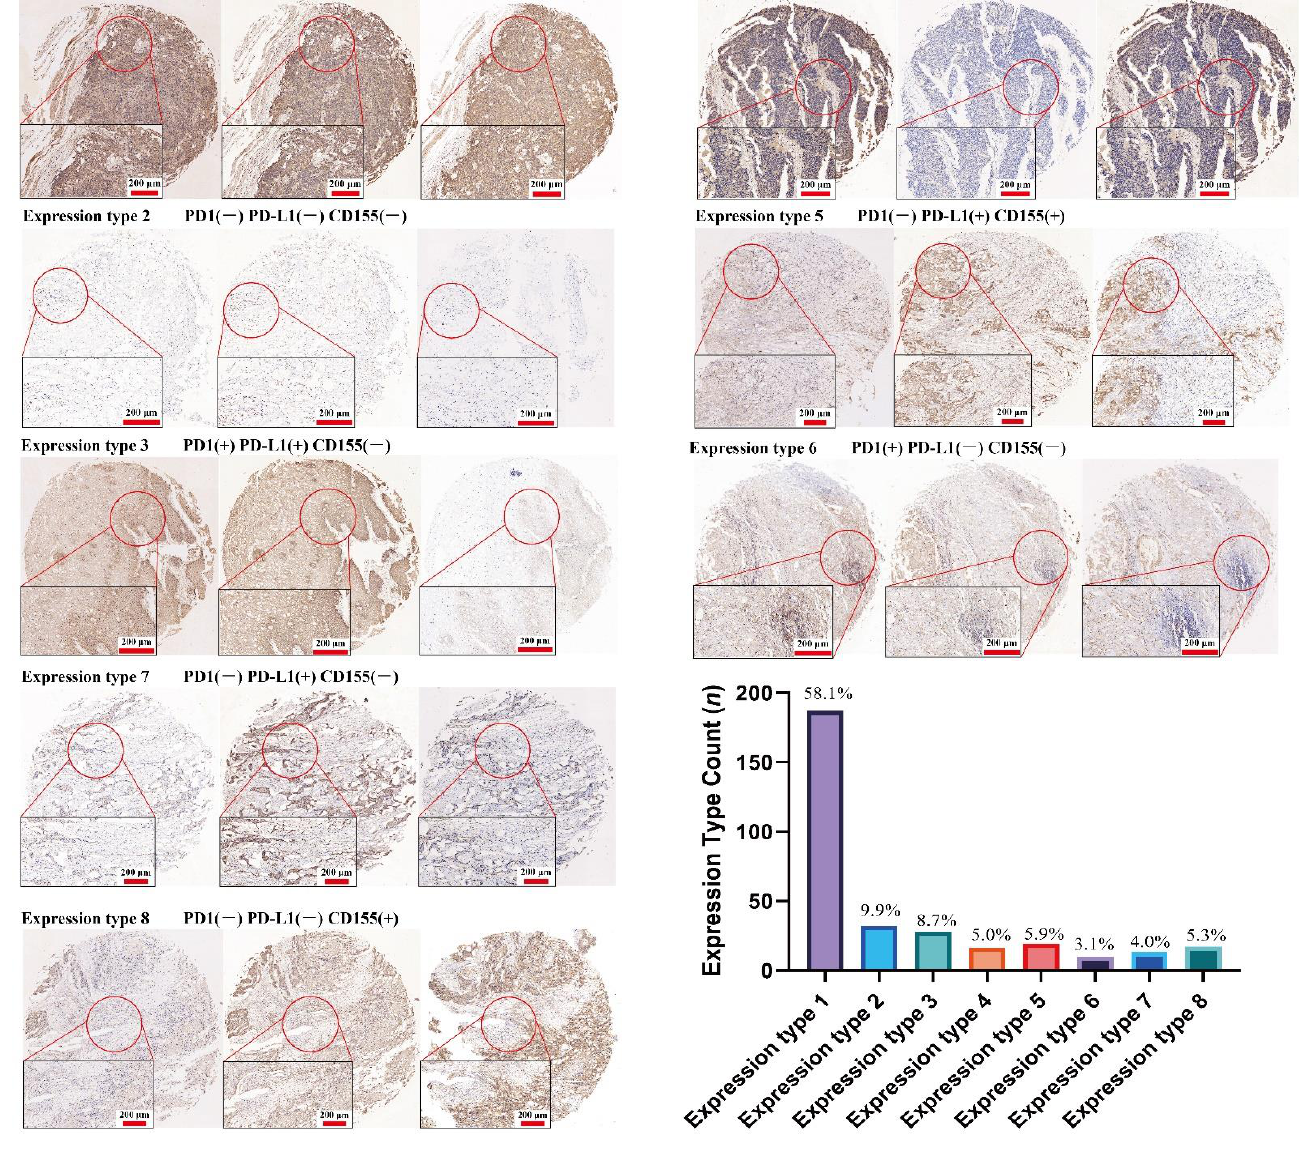
Figure 6. CD155 is tightly associated with PD1/PD-L1. A total of 322 ESCA samples were divided into 8 categories based on the expression type of CD155, PD1, and PD-L1; triple positive samples accounted for 58.1%, and double positive samples, PD1 + CD155 + , or PD-L1 + CD155 + accounted for 10.9%.